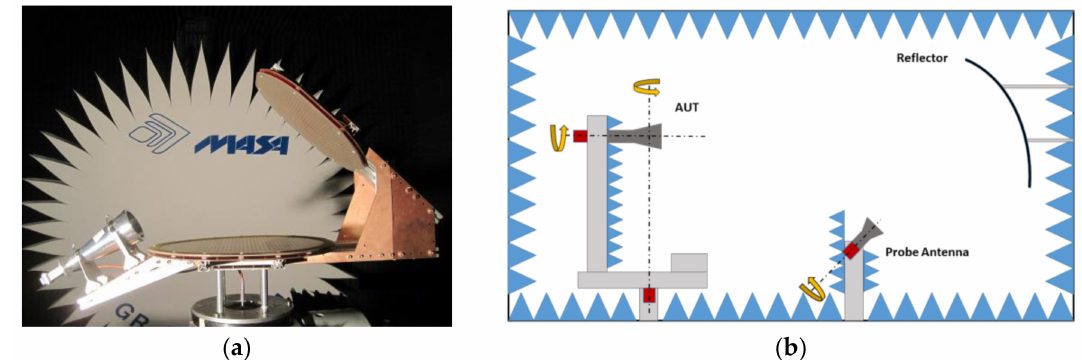
Figure 5. ( a ) Dual-reflectarray antenna for contoured beam in the compact antenna test rage (anechoic chamber) ( b ) Sketch of the CATR measurement system.